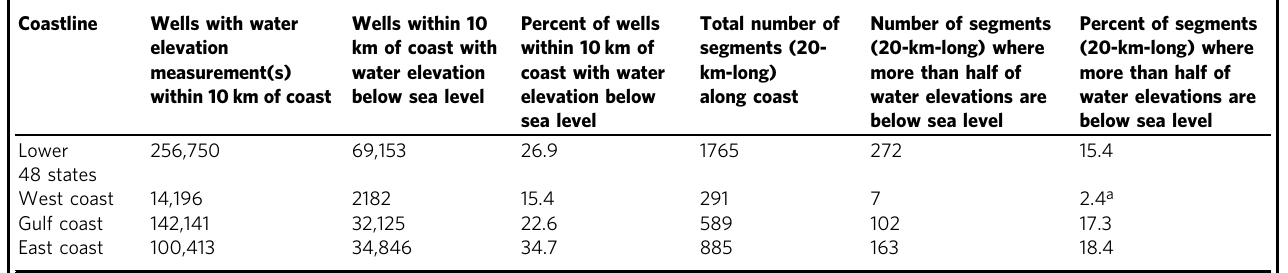
Table 1 Well water elevations along west, gulf and east